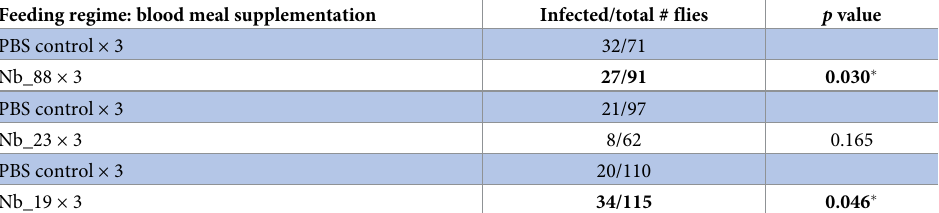
Table 2. In vivo microscopic evaluation of the influence of a blood meal supplementation with 25 μ g/ml Nb on the midgut trypanosome infection establishment. The effect of each Nb was compared to a PBS control in indepen- dent experiments. Differences in infection rates were compared using Chi-square (two-sided) and considered signifi- cant if p-values were lower than 0.05.